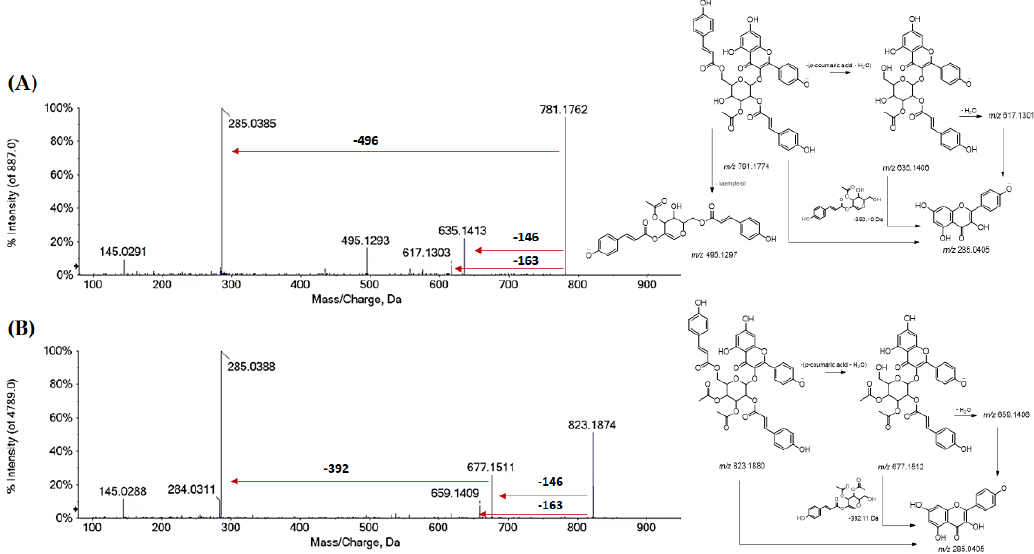
Figure 6. TOF-MS/MS spectra of compound 79 ( A ) and 82 ( B ). Proposed fragmentation pattern for each deprotonated molecular ion is reported. The chemical structure of each fragment ion is depicted and its theoretical m / z ratio is indicated below.